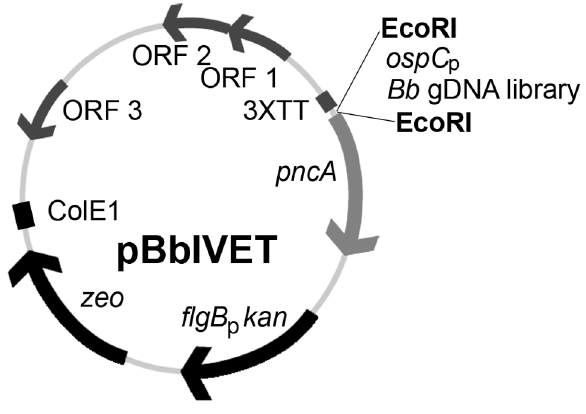
Figure 1. Schematic representation of the pBbIVET vector. Features of this vector include: 3XTT, the transcriptional terminator sequence for bmpB [22] repeated in triplicate; pncA , promoterless pncA gene; flgB p kan , kanamycin resistance cassette; zeo , zeocin resistance marker; ColE1, E. coli origin of replication; ORFs 1, 2, 3, B. burgdorferi cp9 replication machinery. The EcoRI restriction site was used to clone the B. burgdorferi control in vivo -expressed promoter, ospC p , as well as the B. burgdorferi ( Bb ) gDNA library, in front of the promoterless pncA gene. The pBbIVET vector was derived from the B. burgdorferi shuttle vector pBSV2* [80].